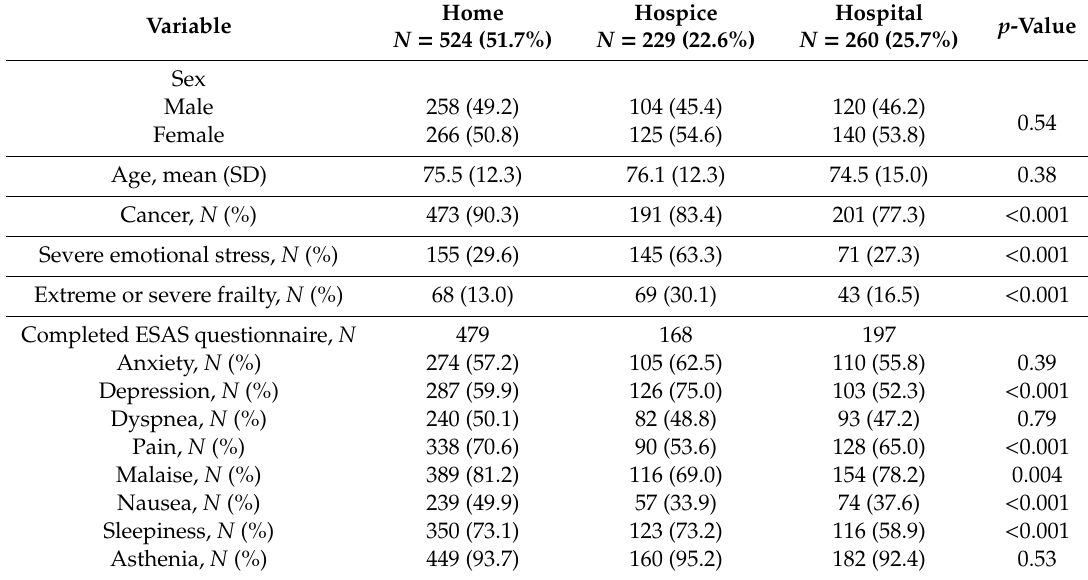
Table 4. Main demanding problems observed in patients who accessed the local palliative care networks, stratified by healthcare